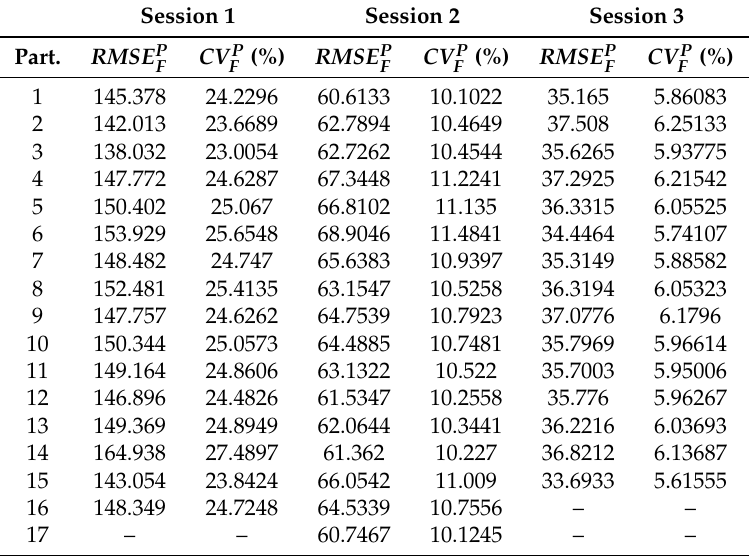
Table 6. Forecast errors of the modified rational expectations model ( F ) for the three